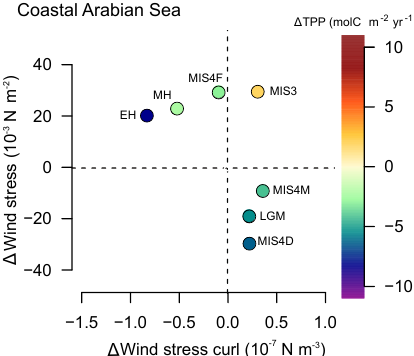
Figure 10. Coastal Arabian Sea seasonal (JJAS) productiv- ity changes (molCm − 2 yr − 1 ) related to wind stress intensity (10 − 3 Nm − 2 , y axis) and wind stress curl intensity (10 − 7 Nm − 3 , x axis) changes compared with the CTRL simulation. The colour scale, x axis range and y axis range are the same as those in Figs. 4 and